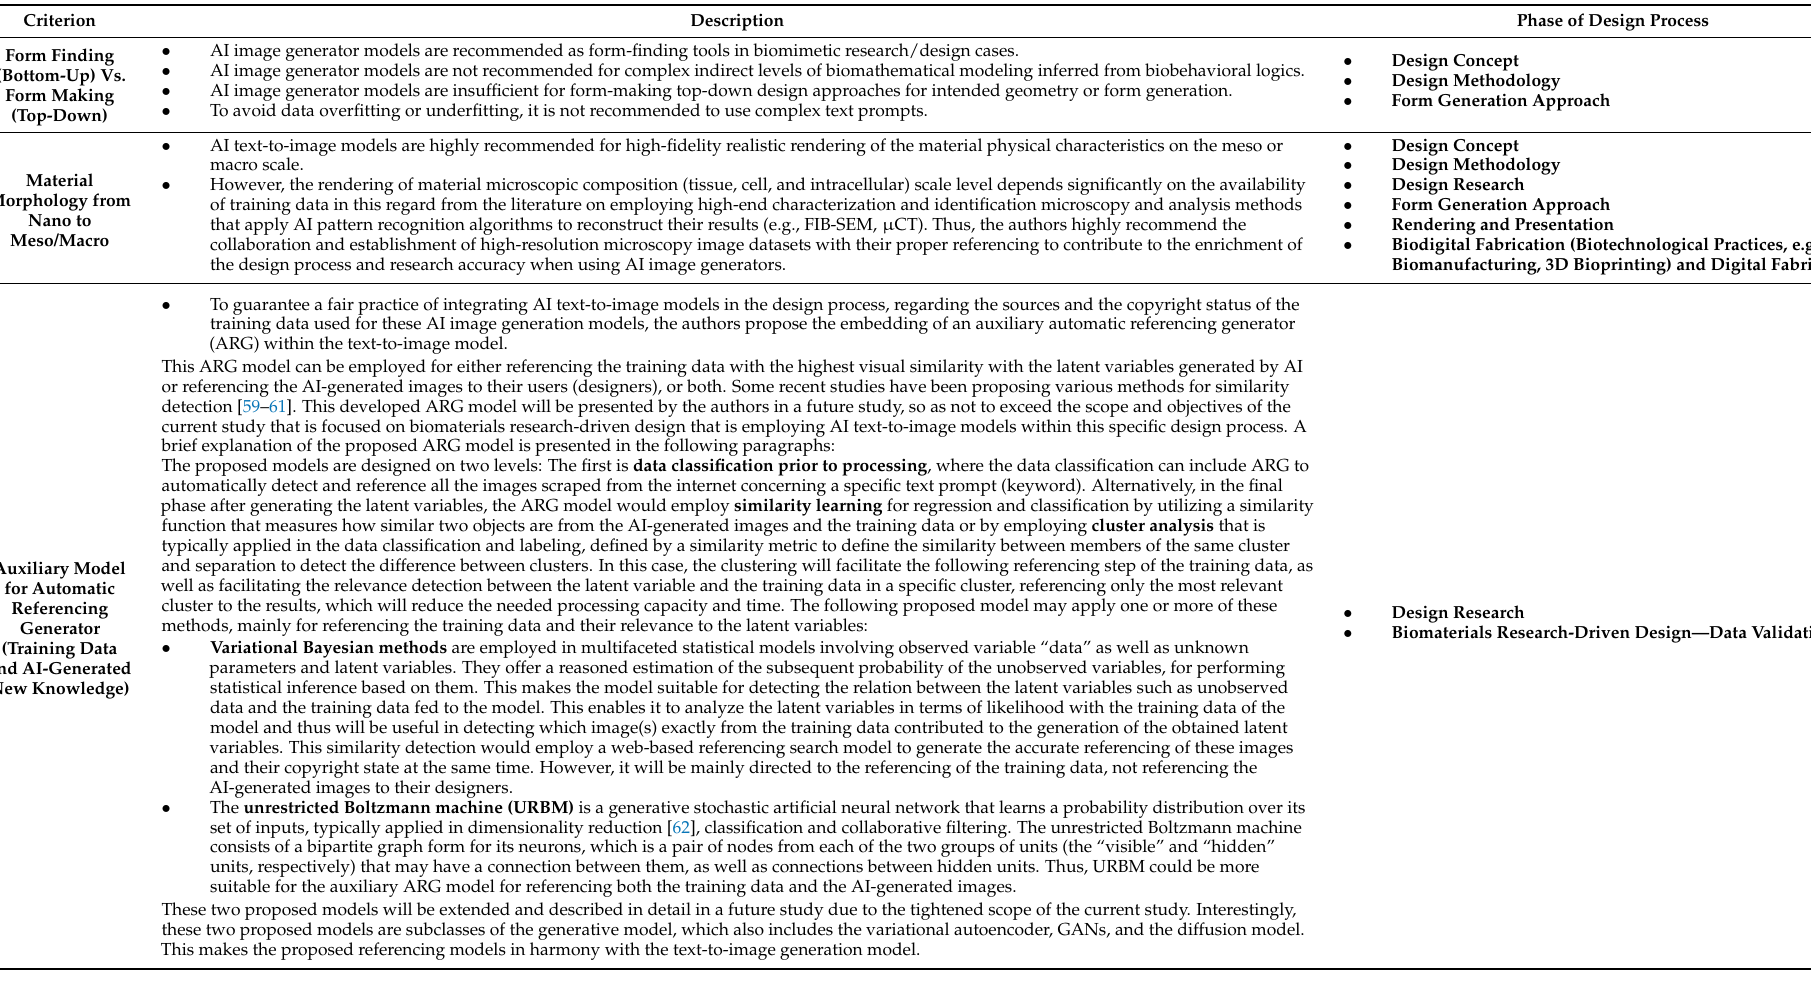
Table 3. The Design Process Criteria for AI-Aided Biomaterials Research-Driven